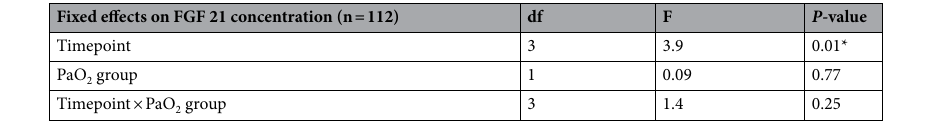
Table 2. Effect of timepoint and PaO 2 group. PaO 2 group, intervention groups targeting normoxia (PaO 2 10–15 kPa) or moderate hyperoxia (PaO 2 20–25 kPa). *Statistically significant at the P < 0.05 level.